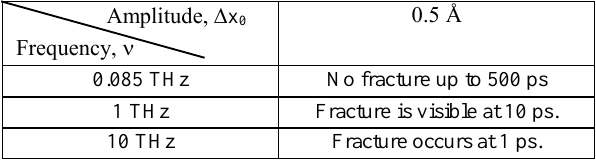
Table 1. The cyclic loading amplitudes and